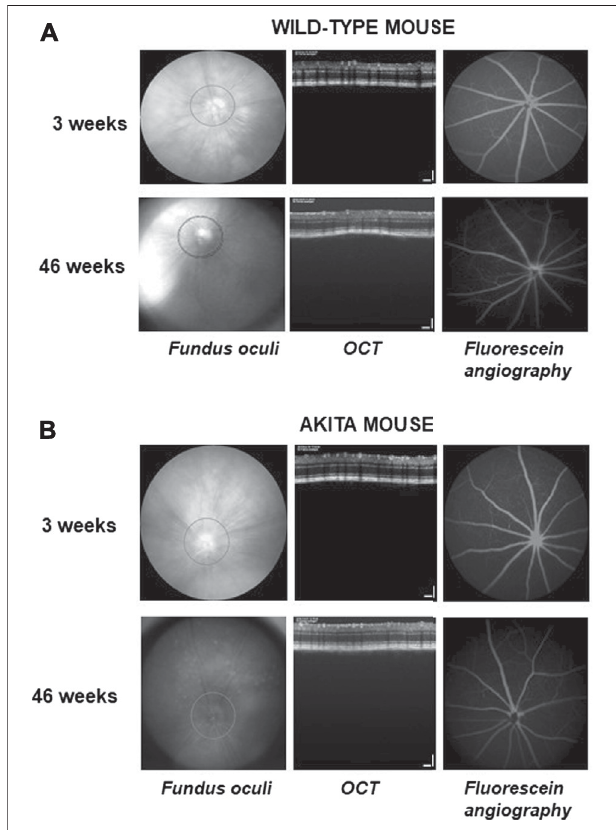
FIGURE 6 | Fundus oculi (left) , optical coherence tomography (OCT; center) and fl uorescein angiography (right) performed during the study in wild-typeand Ins2 Akita animals.Theshownimagesweretakeninthelefteyeof a representative wild-type (A) or Ins2 Akita (B) mice at 3 and 46 weeks of age.